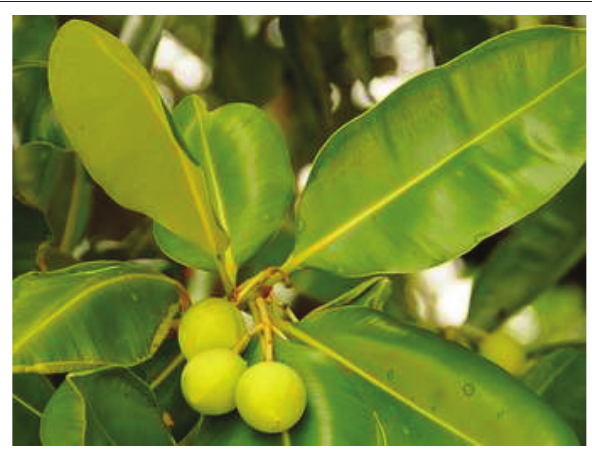
FIGURE 1: Fresh aerial part of Calophyllum inophyllum Linn.